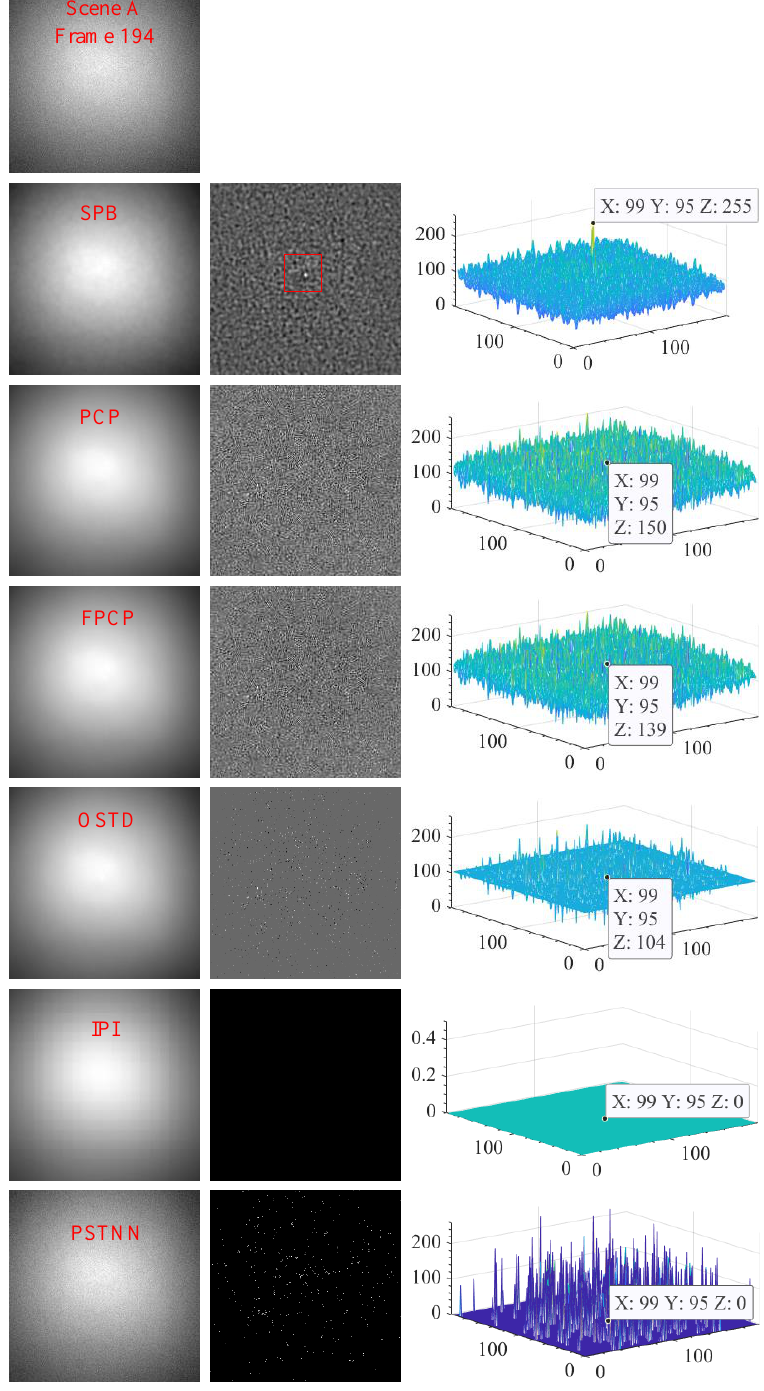
Figure 12. The visual effect of background suppresses of the six algorithms for scene A.